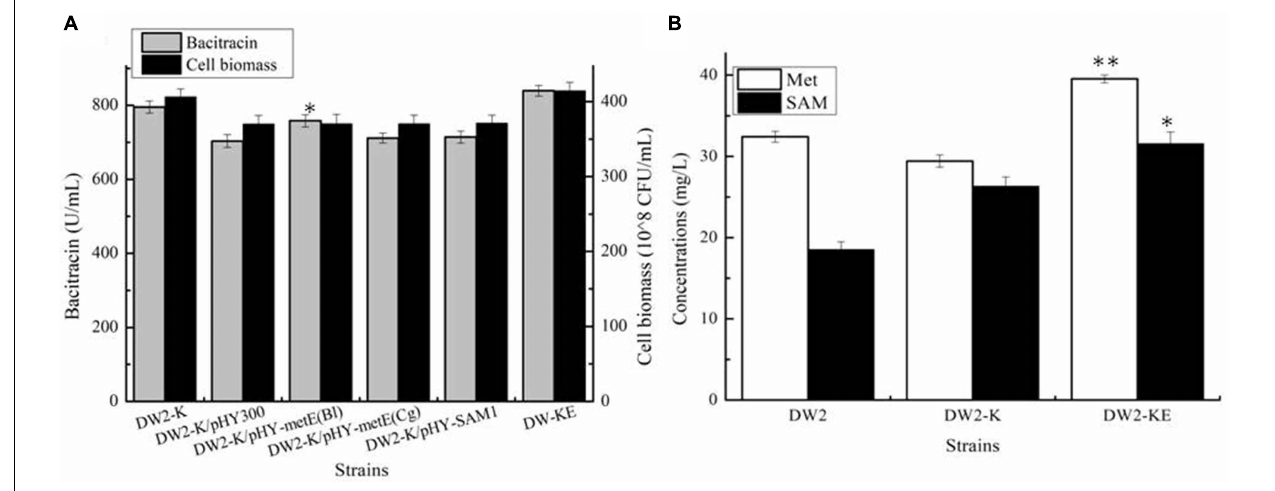
FIGURE 5 | Identifying and engineering Met transporters for enhancement production of bacitracin. (A) The extracellular and intracellular of Met in ME medium, (B) Effects of deletion and overexpression of metN and metP on bacitracin production and cell biomass, (C) The concentrations of intracellular Met and SAM, (D) The concentrations of extracellular Met and SAM, (E) Effects of metN deletion and metP overexpression on bacitracin yields and intracellular SAM concentrations. ∗ P < 0.05 and ∗∗ P < 0.01 indicate the significance levels between recombinant strains and control strain.